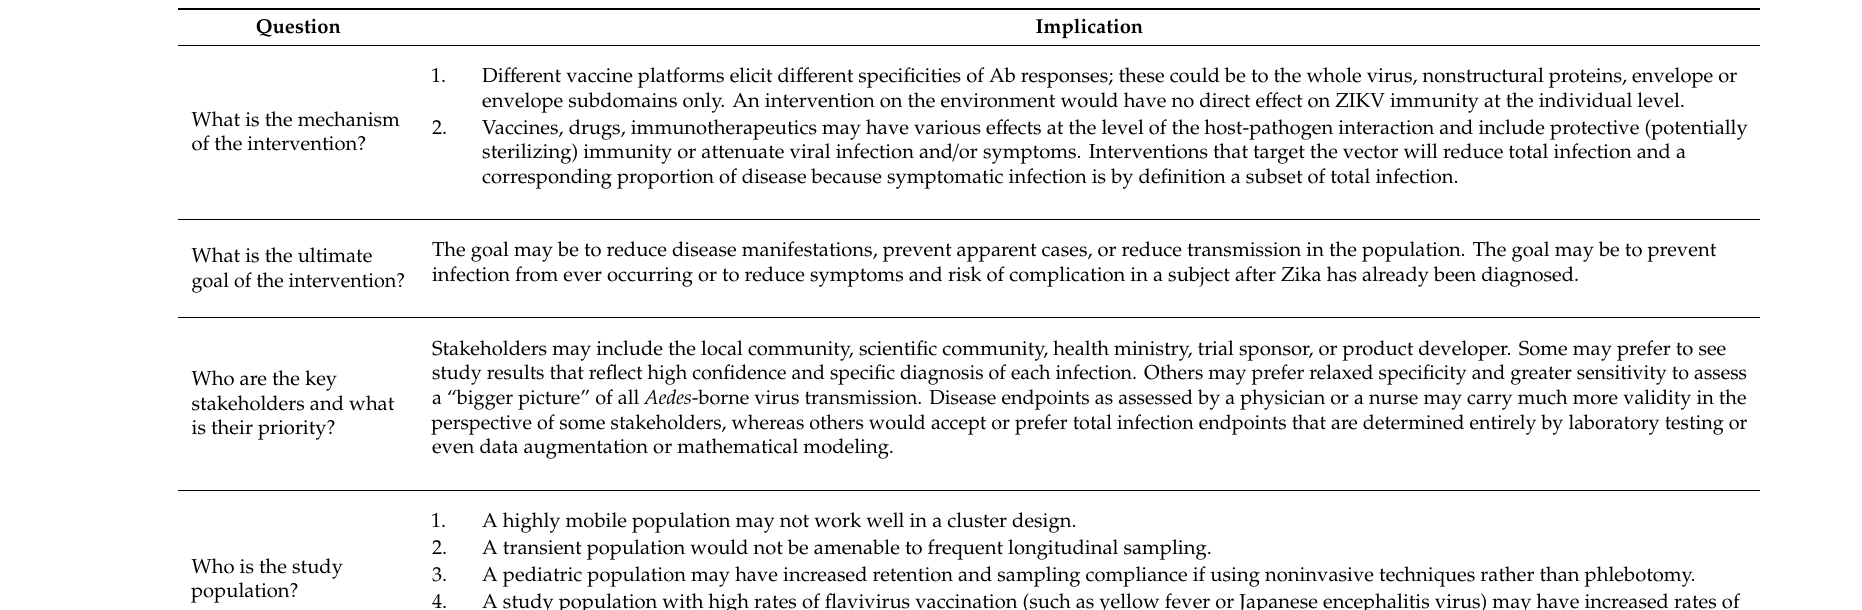
Table 2. Key questions to guide optimal selection and implementation of serologic tools in ZIKV intervention trials. DBS, dried blood